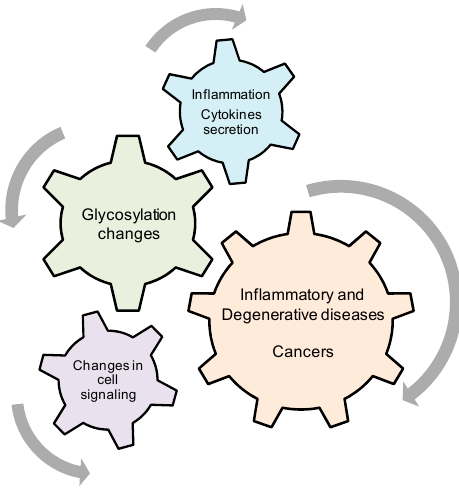
Figure 5. Possible Interplays between Inflammation, Glycosylation, Cell Signaling and Diseases. Pro-inflammatory cytokines induce cell surface glycosylation changes that positively or negatively modulate cell signaling that can cause or reinforce several diseases, including cancers and inflammatory diseases. In the other hand, glycosylation changes can also be involved in the control of inflammation and cytokines secretion.